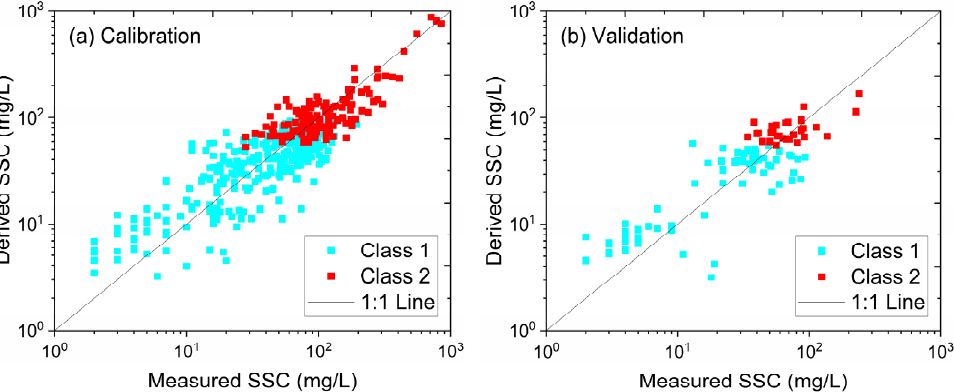
Table 2. Summary of the statistical attributes and model performance using the calibration and validation datasets.